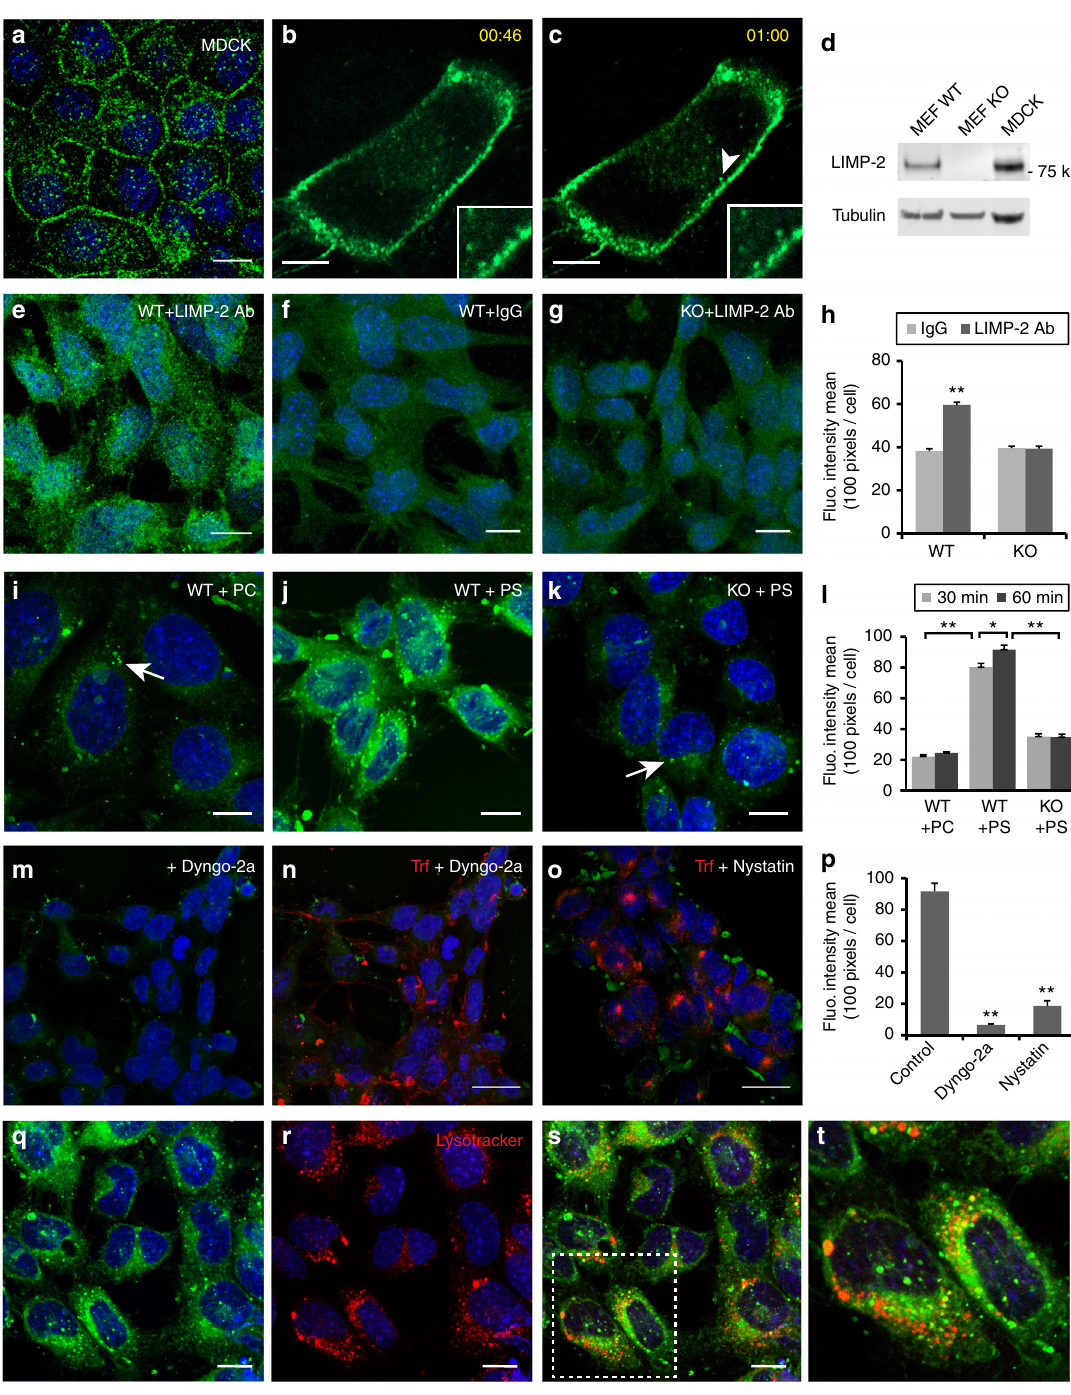
Fig. 5 LIMP-2 mediates the endocytosis of liposomes in cells. a Immunocytochemistry of LIMP-2 in MDCK monolayer culture. Endogenous LIMP-2 proteins (green, nuclear content blue) were found not only inside the cell but also enriched on the cell surface that formed borders between cells. b , c Time-lapse images of a MDCK cell transfected with a LIMP-2-HA construct (enlarged view in insets; time stamp shown in yellow). LIMP-2-HA located on the cell surface was visualized by surface labeling of mouse anti-HA antibody and anti-mouse Fab fragment conjugated to AlexaFluor488. A LIMP-2 containing endocytic vesicle (arrowhead) formed within 14 s was detected in c but not in b . d Western blotting with anti-LIMP-2 antibody. e – g Surface labeling of LIMP-2 in WT or KO MEF. h Quanti fi cation of surface labeling with LIMP-2 or IgG isotype antibody. i – k 30 min uptake of PC or PS liposomes in MEF. i WT MEF with few intracellular PC particles (arrow). j WT MEF with intracellular PS particles (green). k LIMP-2 KO MEF with few intracellular PS particles (arrow). l Quanti fi cation of liposome uptake in WT and LIMP-2 KO MEF. m , n Dyngo-2a (100 μ M, 15 min) blocks both PS liposome (green) uptake and transferrin (red) endocytosis. o Nystatin (100 μ M, 15 min) inhibits the endocytosis of PS liposome (green) but not transferrin (red). p Quanti fi cation of PS fl uorescence intensity in WT MEF treated with endocytosis inhibitor Dyngo-2a or nystatin. q – t Endocytosed PS vesicles (green) were partially localized to lysosomes (lysotracker, red) after 60 min of uptake. t Enlarged view of the square in s . Results are expressed as means ± SE. *, t test P = 3.8E − 4; **, t test P < 2.2E − 14. Blue, DAPI. Scale bar: a – k , 12 µ m; m – o , 25 µ m; q – t , 12 µ